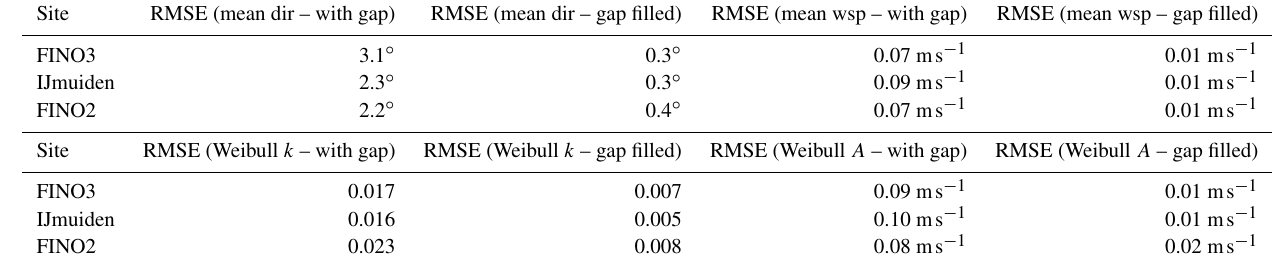
Table 3. RMSE derived for the four statistics considered in this study for time series with gaps and gap-filled time series of wind speed and direction for the three investigated